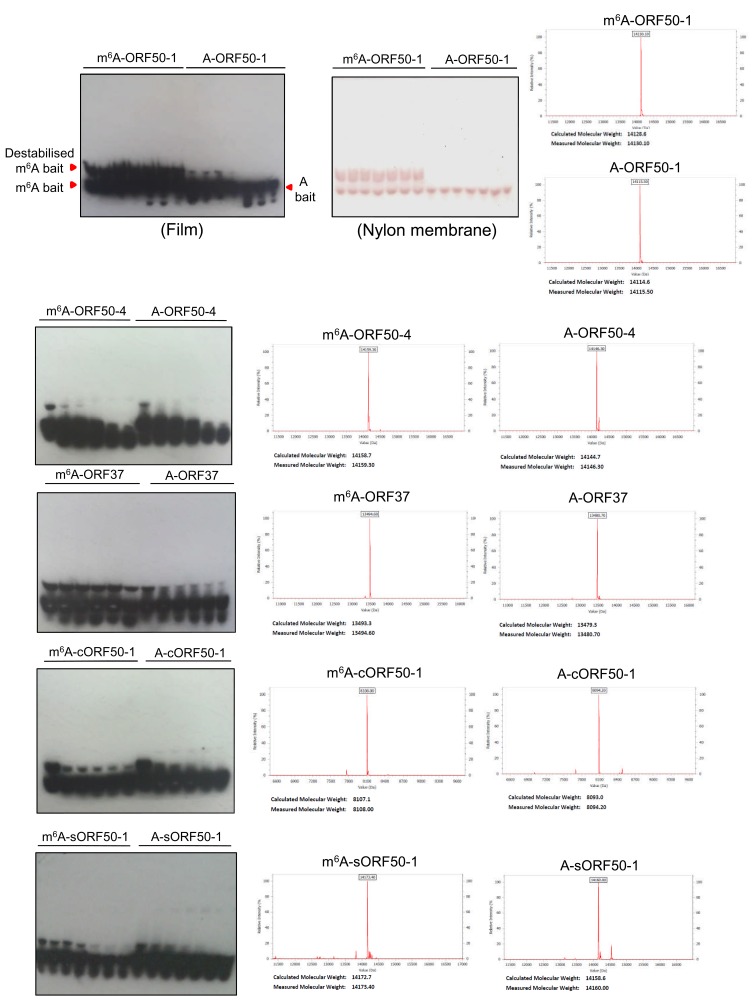
A fraction of free m6A-ORF50-1 bait migrates slower than A-ORF50-1 bait.Representative native EMSA using ORF50-1 baits on their own without any protein addition using a one second film exposure to detect the baits. Two free bands in m6A-ORF50-1 bait are observed more clearly in the burn out nylon membrane after ECL exposure. Corresponding electrospray ionisation (ESI) of the baits are shown. Representative native EMSAs for the rest of the baits from EMSAs that did not result in a positive shift and applying one second film exposure. All ESI traces were provided by Integrated DNA Technologies, the manufacturer of the biotinylated RNA baits.